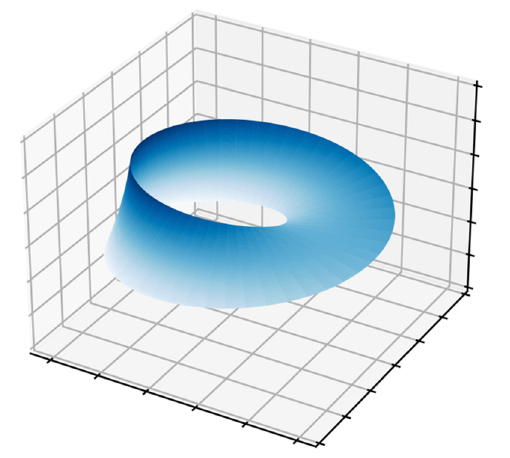
Figure 1. Paradoxical concept: The Möbius strip.